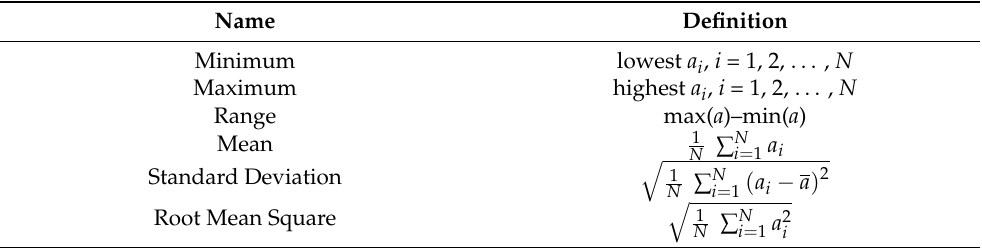
Table 1. List of features used (notation: a ∈ ( x , y , z , m ) ; N is the number of data points; i is the